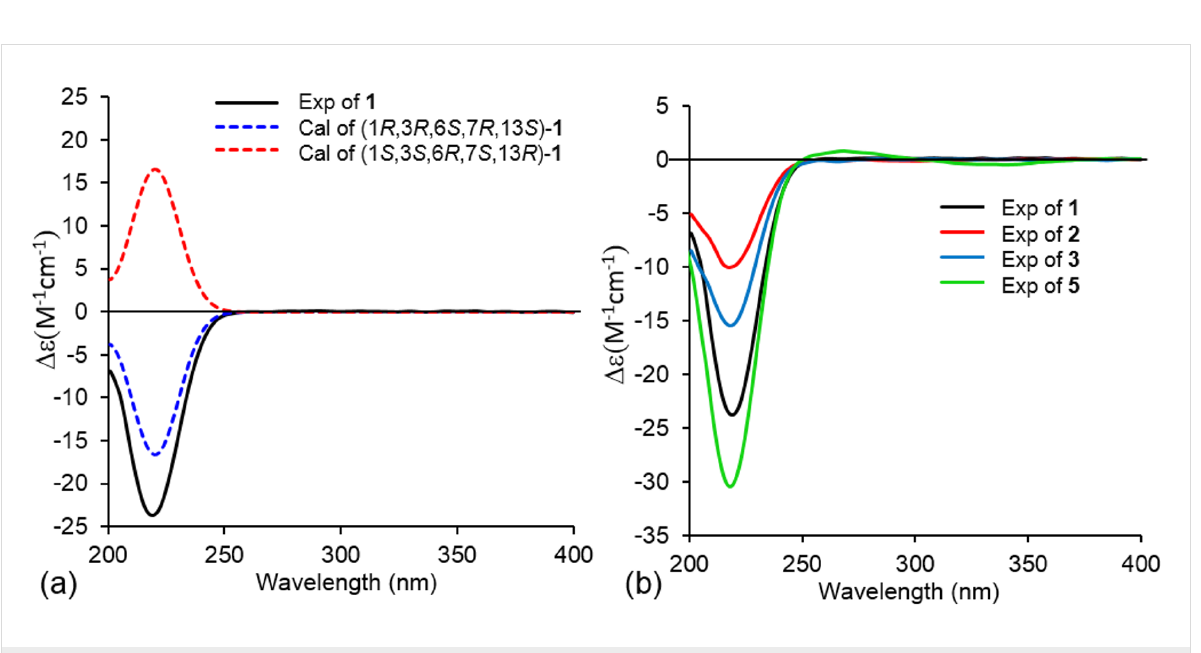
Figure 4: (a) Experimental ECD spectrum of 1 (MeOH) compared to TDDFT-calculated spectra (B3LYP-D3/def2-TZVPP) for the two possible enan- tiomers of 1 , which were blue-shifted by 9 nm. (b) Comparison of experimental ECD spectra of 1 – 3 and 5 (MeOH).